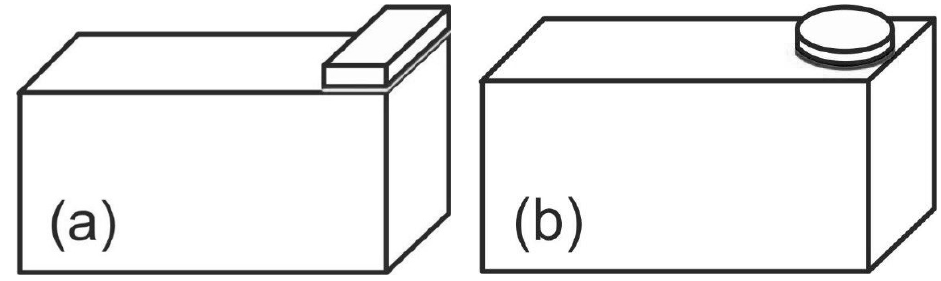
Figure 3. Block specimen with upper element: ( a ) according to ISO 9653; ( b ) disc ‐ shaped.